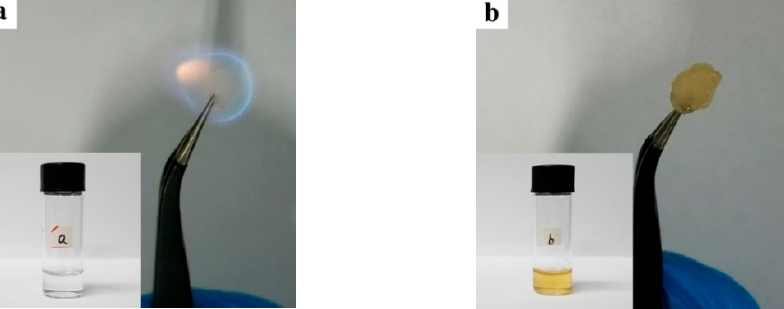
Figure 4. Photos of ( a ) the lighted degreased cotton that was dipped into the PC/EC (1:1) electrolyte; ( b ) the degreased cotton that was dipped into the TLPEC electrolyte and lit with a lighter.